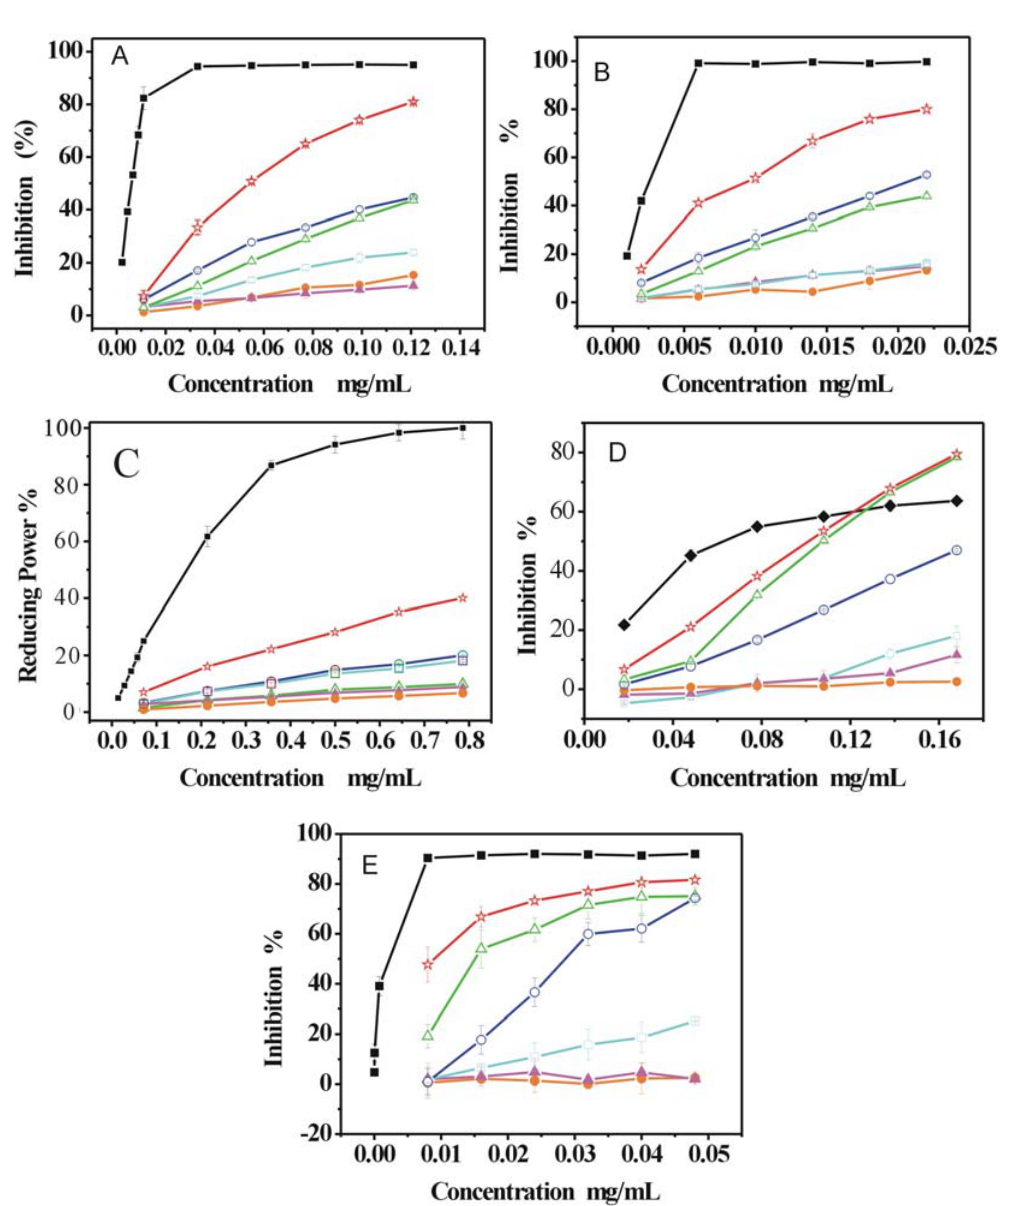
Figure 1. Effect of different concentration of extracts of Radix Angelicae Sinensis in free radical scavenging tests: (A) DPPH assay, (B)ABTS assay, (C) Reducing power assay,(D) Superoxide anion assay, (E) Lipid peroxidation